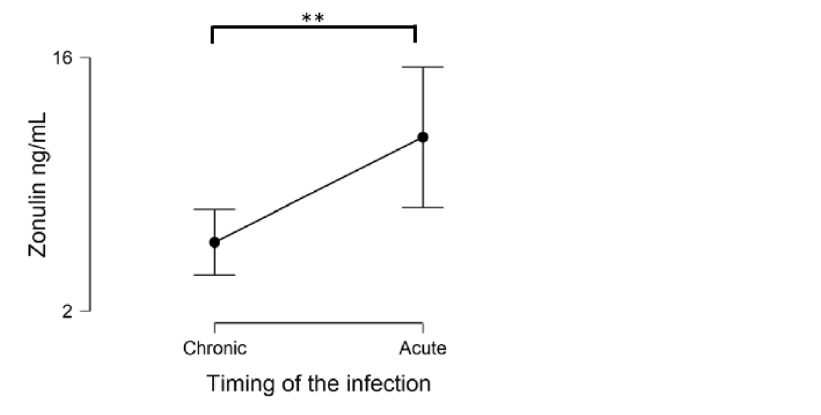
Figure 2. Levels of Zonulin based on the timing of the infection. **: p < 0.05.